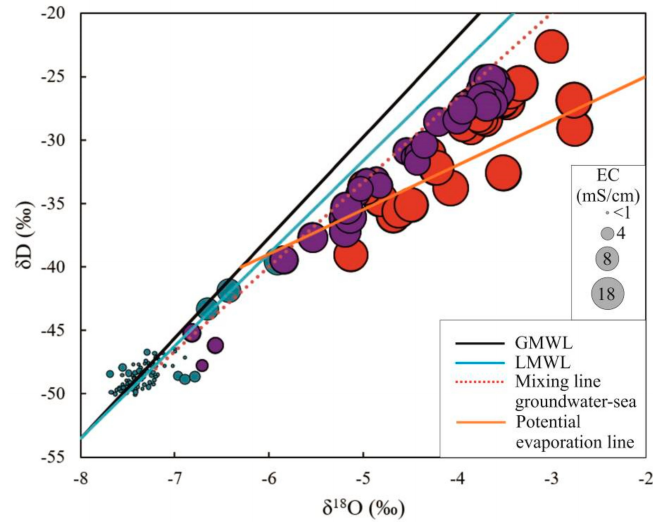
Figure 5. δ 18 O and δ D of groundwater samples with the Global Meteoric Water Line (GMWL), the Local Meteoric Water Line (LMWL), a mixing line between fresh groundwater in the study area, and the sea ( δ 18 O and δ D: 0% (cid:24) , 0% (cid:24) ), and a potential evaporation line. Colors indicate the sample categories from Figure